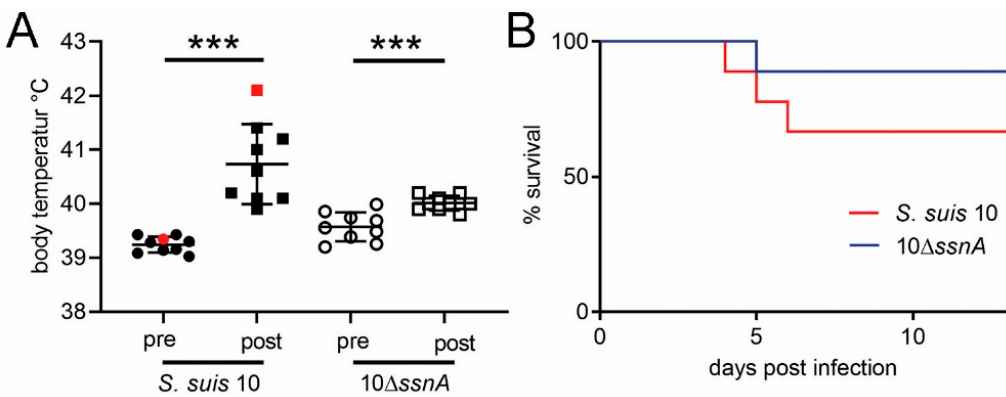
Figure 1. The DNase mutant S. suis 10 ∆ ssnA suggest only a slight attenuation in pigs. The body temperature and survival rate after intranasal infection with S. suis is presented: ( A ) The body temperature increased in both infection groups post-infection. Data shown as mean ± SD. Each dot represents one animal, red marks show animals with meningitis. Statistical analysis: one-tailed, paired Student’s t -test was calculated in each infection group. Values post-infection present the highest measured value. *** p < 0.001. ( B ) The Kaplan–Meier survival curve shows a slightly higher but not significant mortality in the S. suis 10-infected group (Statistical analysis: Log-rank (Mantel–Cox) test, p = 0.26, each group n = 9).